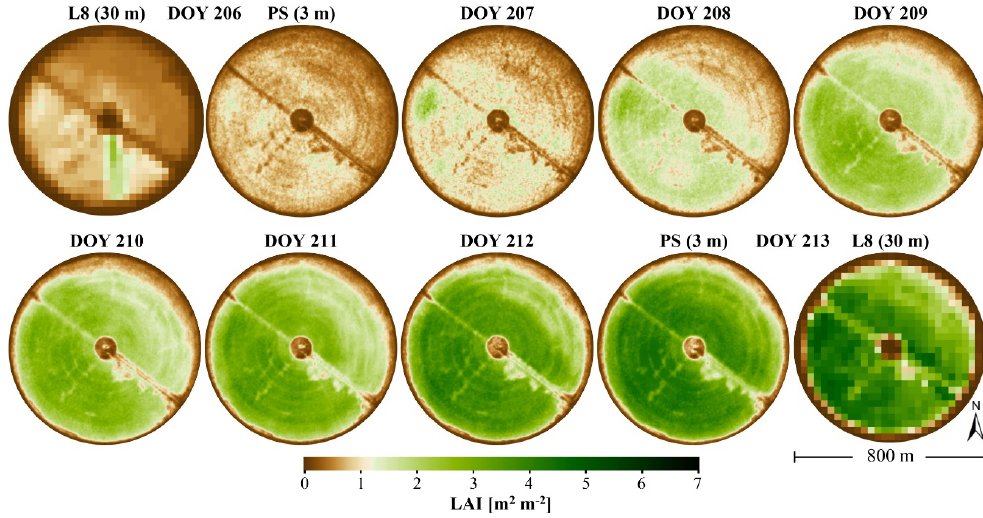
Figure 7. Daily sequence of 3 m resolution PlanetScope (PS) LAI bounded by 30 m resolution Landsat 8 (L8) retrievals on DOY 206 and 213. The imagery captures a vegetative phase in the alfalfa field as indicated by the shaded area in Figure